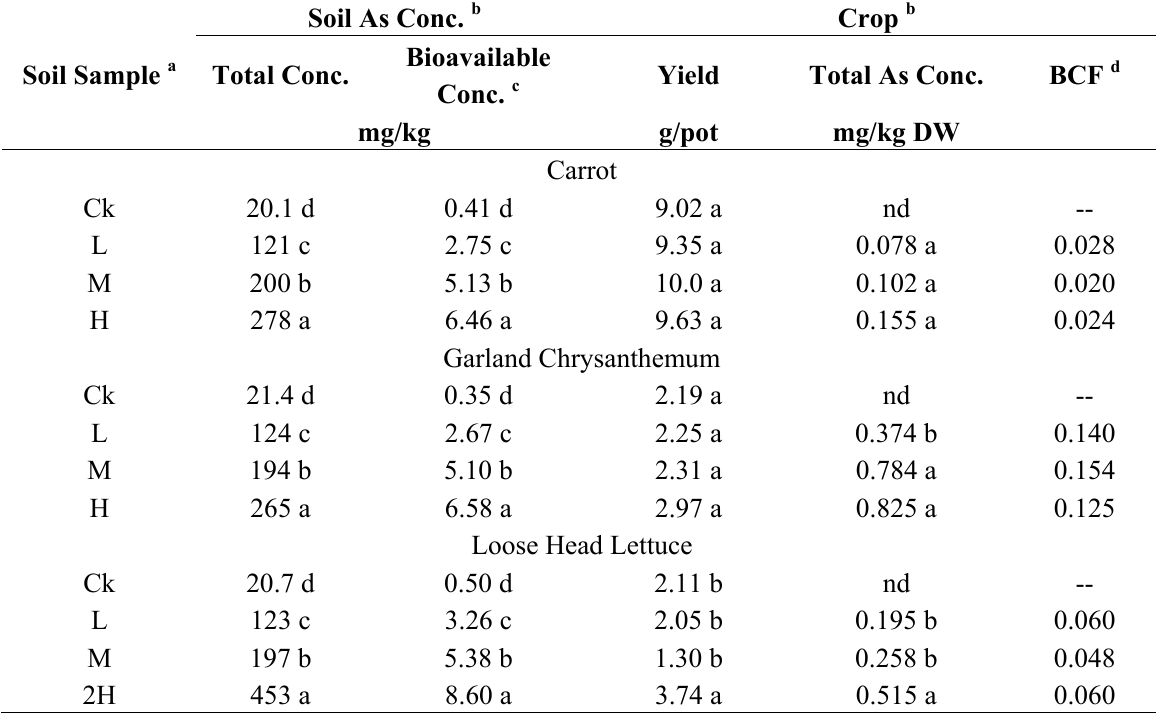
Table 1. As concentrations in soil samples and corresponding crop yields and As concentrations in edible parts of different